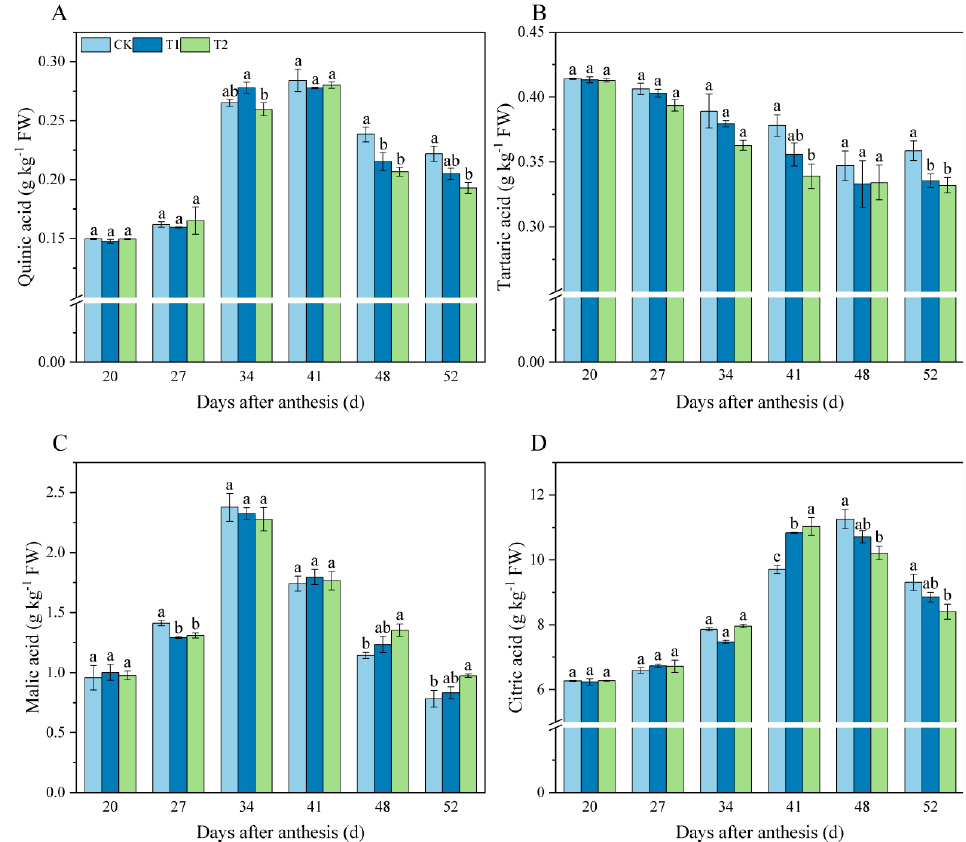
Figure 2. Effects of exogenous melatonin on organic acid components content in tomato fruit. ( A ) Quinic acid. ( B ) Tartaric acid. ( C ) Malic acid. ( D ) Citric acid. Results are means ± SE of three independent replications. Different letters represent significant differences between treatments ( p < 0.05).